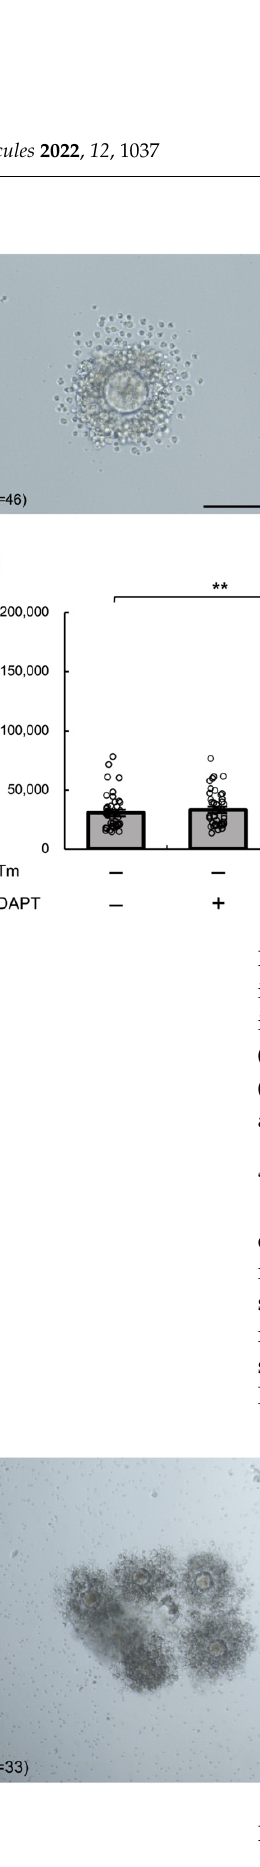
Figure 7. Notch signaling mediates COC expansion in PCOS model mice. Mice were injected sub- cutaneously with DHEA (60 mg/kg body weight) (PCOS, n = 4 or PCOS + DAPT, n = 4) or sesame oil (control, n = 4) daily for 20 days. Mice were injected intraperitoneally with 10 IU PMSG followed 48 h later with 10 IU hCG. After PMSG injection, mice were injected intraperitoneally with DAPT (25 mg/kg) (PCOS + DAPT) or DMSO (control or PCOS) every 24 h. Mice were euthanized at 14 h after hCG injection. COCs were isolated from oviducts. ( A – C ) Representative microscopic images of COCs harvested from each group of mice: ( A ) control, ( B ) PCOS, and ( C ) PCOS treated with DAPT. The scale bars indicate 200 µm. ( D ) Quantitative analysis of the areas of COCs. Values rep- resent means ± SEM. ** p < 0.01. 4. Discussion The present study shows that expression of Notch2 and the Notch-target transcrip- tion factors Hey2 and Hes1 is higher in granulosa cells of antral follicles of PCOS patients and a mouse model of PCOS than in those of control participants and control mice, re- spectively. ER stress, which is activated in granulosa cells of antral follicles in PCOS, in- creased expression of Notch2 and Hey2 in cultured human GLCs, and this was mediated by the UPR branch involving ATF4. ER stress increased the expression of genes associated with COC expansion in cultured human GLCs and enhanced the expansion of cumulus cells in cultured murine COCs, and these effects were abrogated by inhibition of Notch signaling. Finally, COC expansion was enhanced in PCOS model mice, and inhibition of Notch signaling reduced the areas of COCs in these mice. Expression of Notch2, Hey2, and Hes1, which are the most typical Notch receptor and target transcription factors of Notch signaling in granulosa cells of antral follicles, is increased in these cells in PCOS, indicating that Notch2 signaling is induced in PCOS. Existing findings about Notch in PCOS ovaries are quite limited and conflicting. Further- more, most of them are based on transcriptome profiling of Notch and/or target genes, without examination of protein expression [13–20]. In addition, all existing reports about granulosa cells utilized human GLCs or cumulus cells harvested at IVF after ovarian stim- ulation. Bioinformatic analysis showed that Notch signaling pathways are enriched in PCOS [20]. Notch1 and Notch2 mRNAs were upregulated in GLCs/cumulus cells of PCOS